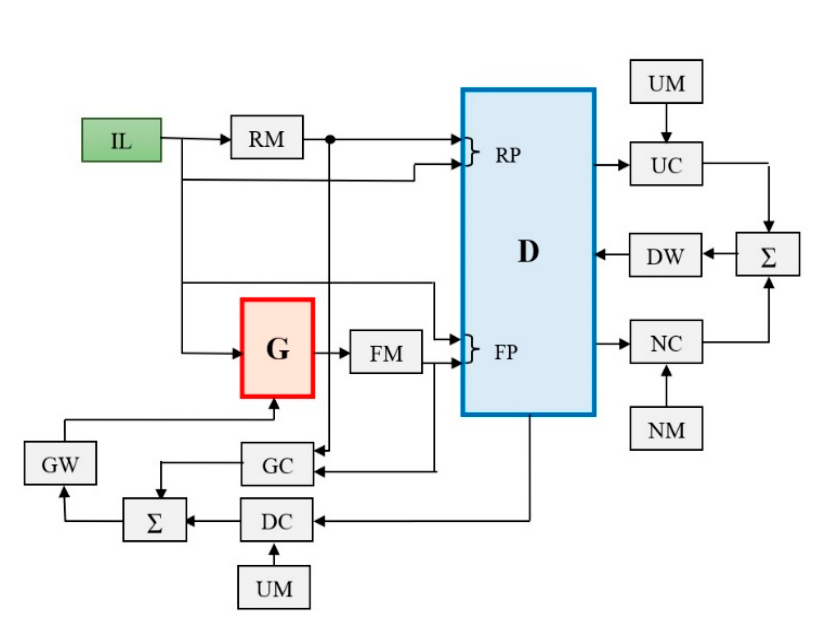
Figure 6. Block diagram of the cGAN based system for flood and vegetation detection. The following